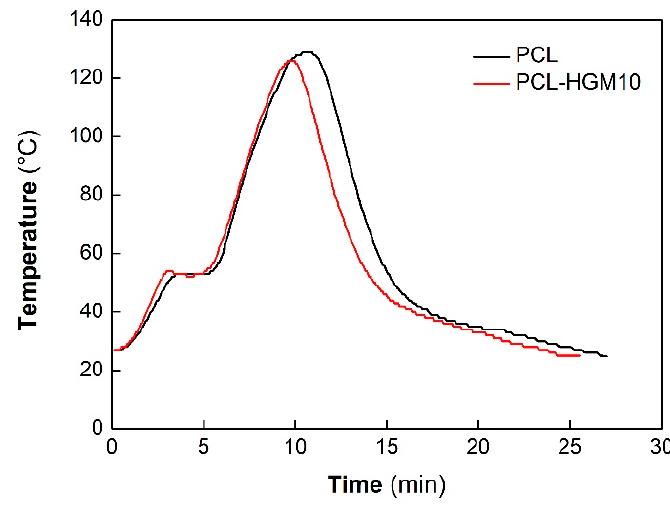
Figure 11. Internal air temperature as a function of time during rotomolding tests.